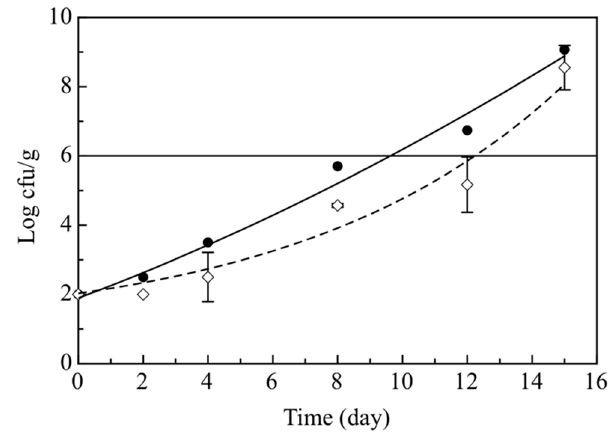
Figure 2. Evolution during 15 days of storage at 4 ◦ C of Pseudomonas spp. in the breaded cod sticks. The curves are the best fitting of the experimental data. ( • ) Control breaded cod sticks without olive paste (Ctrl) ( ♦ ) Active breaded cod sticks with olive paste (Active).